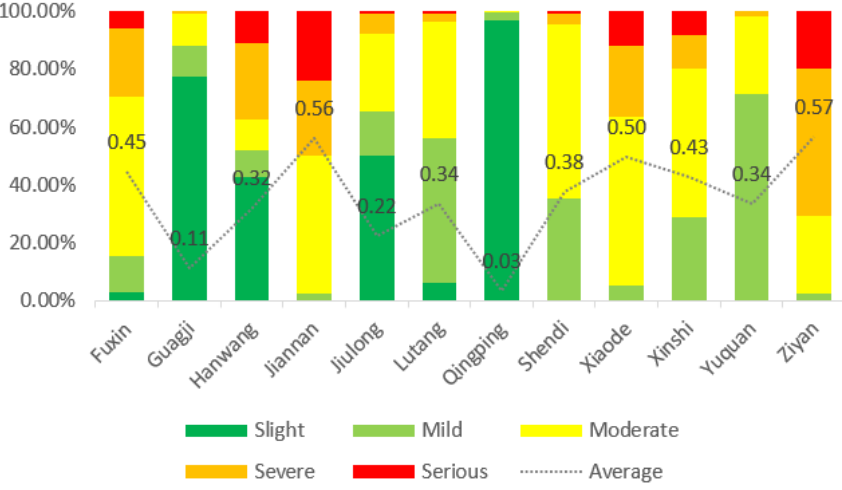
Figure 7. Distribution of townships disturbed by human activity.